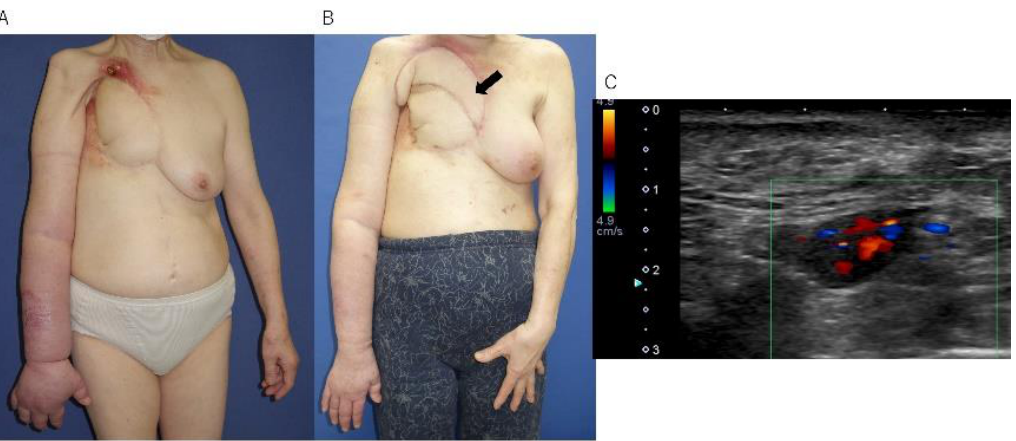
Figure 3. ( A ) A 72-year-old female patient suffered from right upper extremity lymphedema with a chronic wound on the thoracic wall after a mastectomy and radiotherapy. ( B ) After a vascularized lymph node transfer and chest wall reconstruction, the arm volume reduced by 275.0 m. The black arrow indicates the location of the transferred lymph nodes (LNs). ( C ) At 6 months after surgery, blood flow was clearly detected in the LNs.